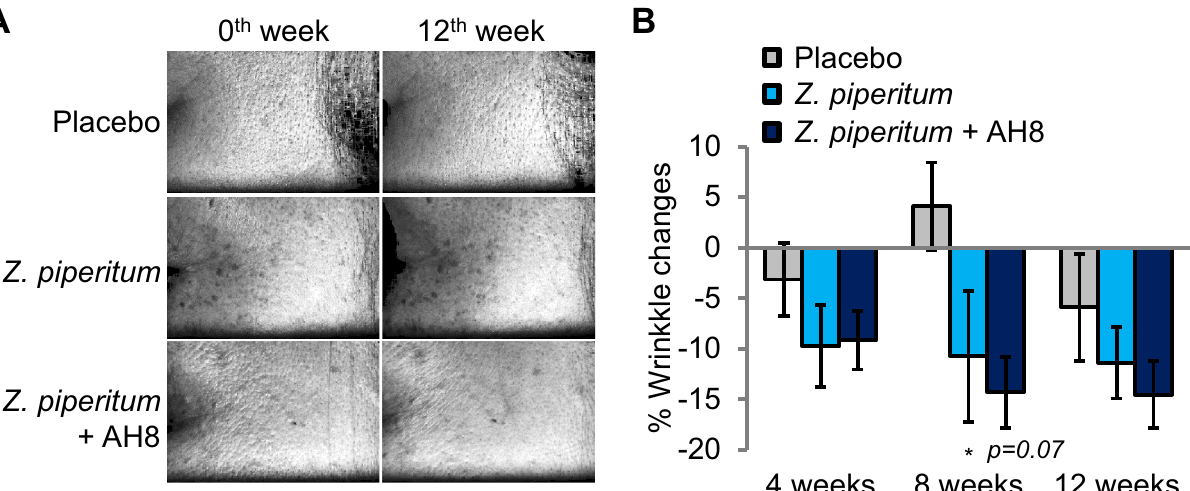
Figure 4. Wrinkle-reducing effect of Z. piperitum extract. ( A and B ) Improvement of the lateral canthal rhytides (Crow’s feet) by topical treatment of Z. piperitum extract and acetyl hexapeptide-8 (AH8) ( A ) and the quantification ( B ). Topical treatment of Z. piperitum extract for improved lateral canthal rhytides. In addition, topical treatment of Z. piperitum extract and acetyl hexapeptide-8 (AH8) together tended to improve